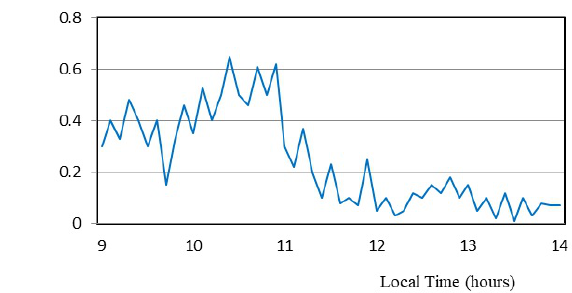
25.7 ′′ has been calculated according to Eq. (1), which has been used to determine the true value of refraction r for each moment of observation.